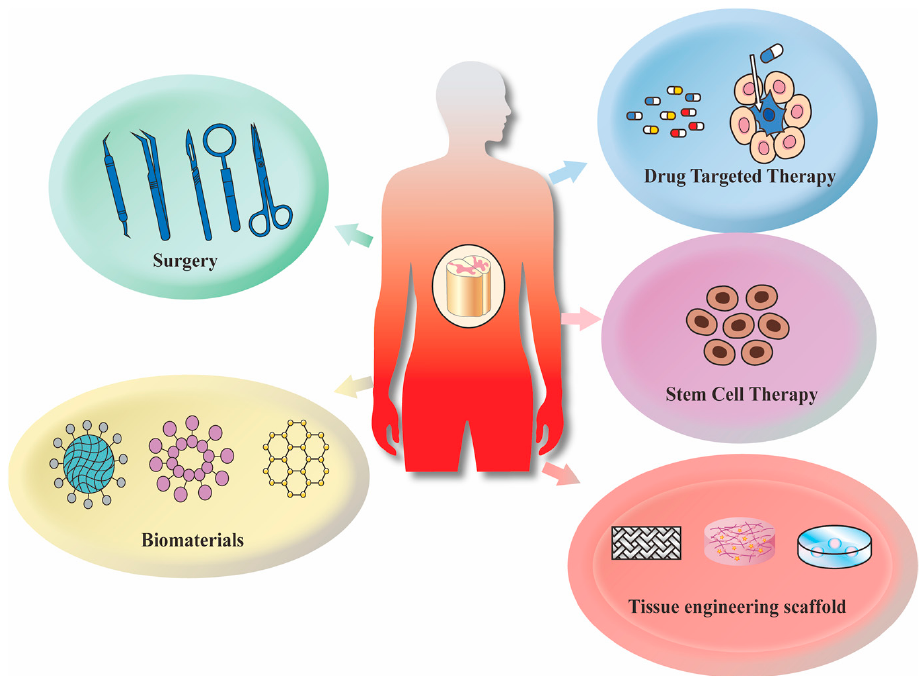
Figure 2. Current treatments for SCI include surgery, drug-targeted therapy, biomaterials, stem cell therapy, and tissue engineering scaffolds.